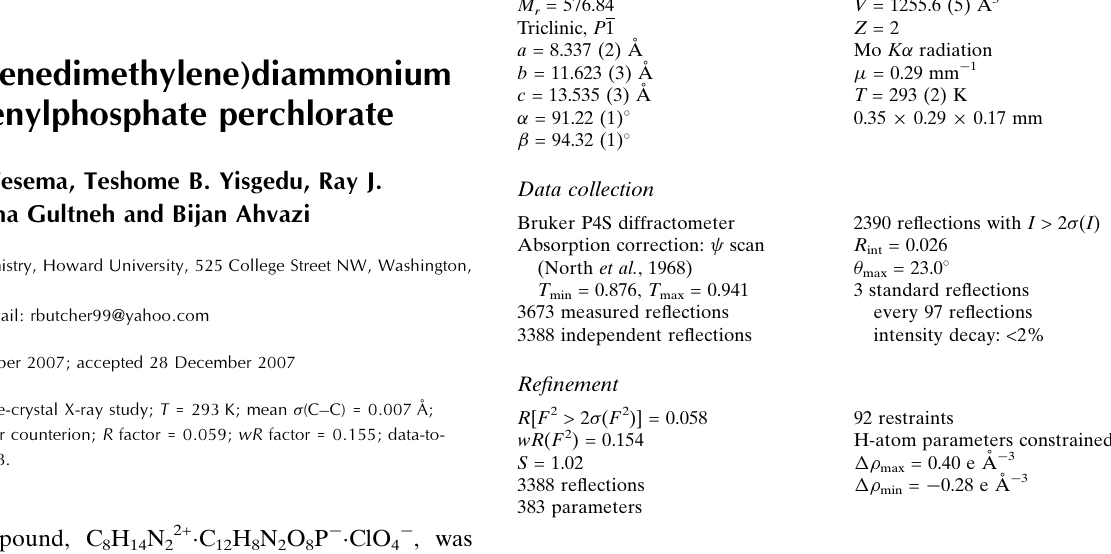
Key indicators: single-crystal X-ray study; T = 293 K; mean (cid:1) (C–C) = 0.007 A˚; disorder in solvent or counterion; R factor = 0.059; wR factor = 0.155; data-to- parameter ratio = 8.8.